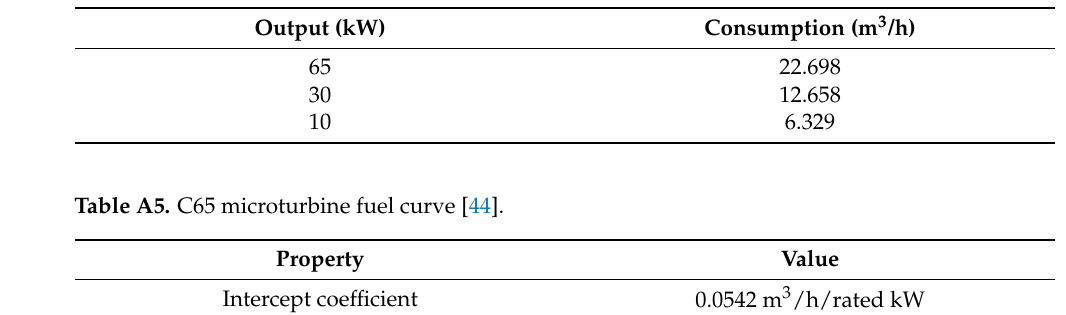
Table A4. Microturbine consumption [44].